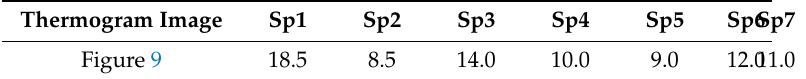
Table 6. The temperature ( ◦ C) of the spots on the Olea europaea L. thermogram (Figure 9). Thermogram